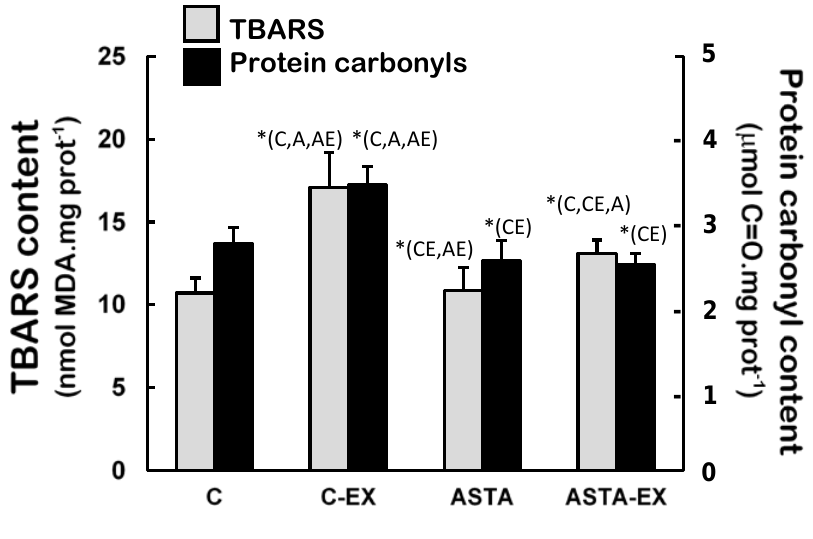
Figure 6. Concentration of biomarkers of oxidative modifications in lipids (TBARS assay) and proteins (protein carbonyls) in soleus muscles of Wistar rats submitted to exhaustion (forced swimming activity with additional 5% BW) and supplemented for 45 days with 1 mg ASTA/kg BW or mineral oil (control). ( n = 6).* ( p < 0.05), compared to: control (C), control exhausted (CE), ASTA-fed (A), or ASTA-fed exhausted